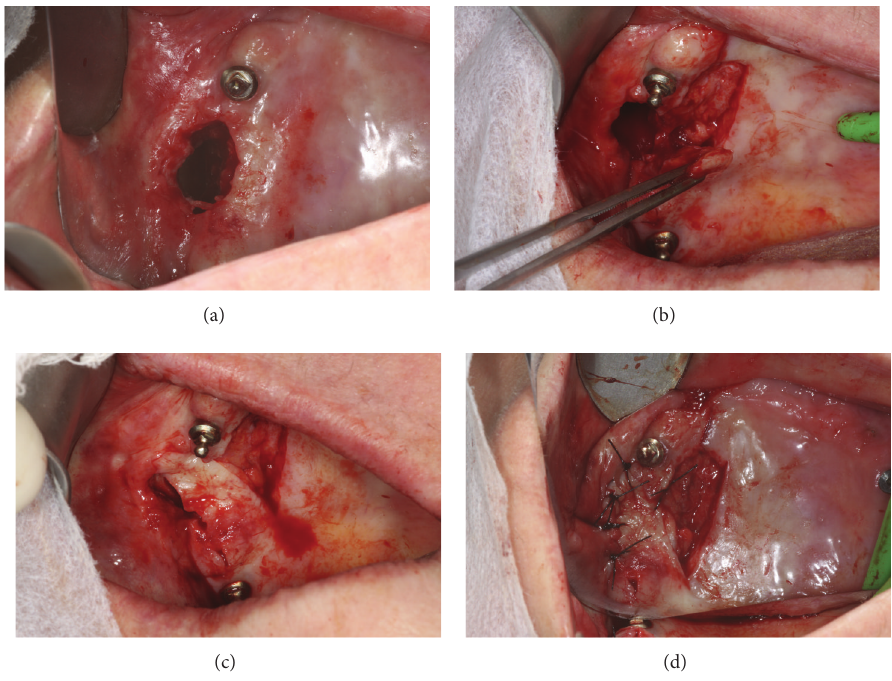
Figure 2: During the surgical procedure (a) an incision was made to allow for the removal of the soft tissue collar. The bone lesion was 12 mm in diameter. A pedicle flap was (b) elevated, (c) laterally slid to cover the defect without tension, and (d) sutured while maintaining a bare surgical bed covered by the periosteum and a thin layer of connective